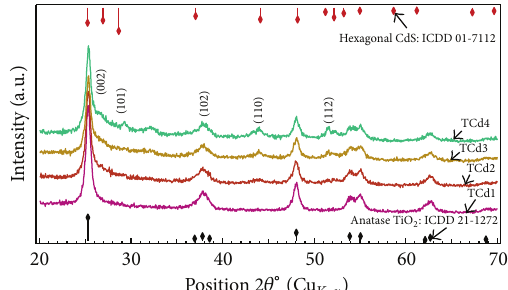
Figure 1: Powder XRD patterns of the TiO 2 -CdS photocatalysts sys- tems. Standard diffraction (stick) patterns of bulk anatase TiO 2 (bottom black) and bulk hexagonal CdS (top red) are shown as references.